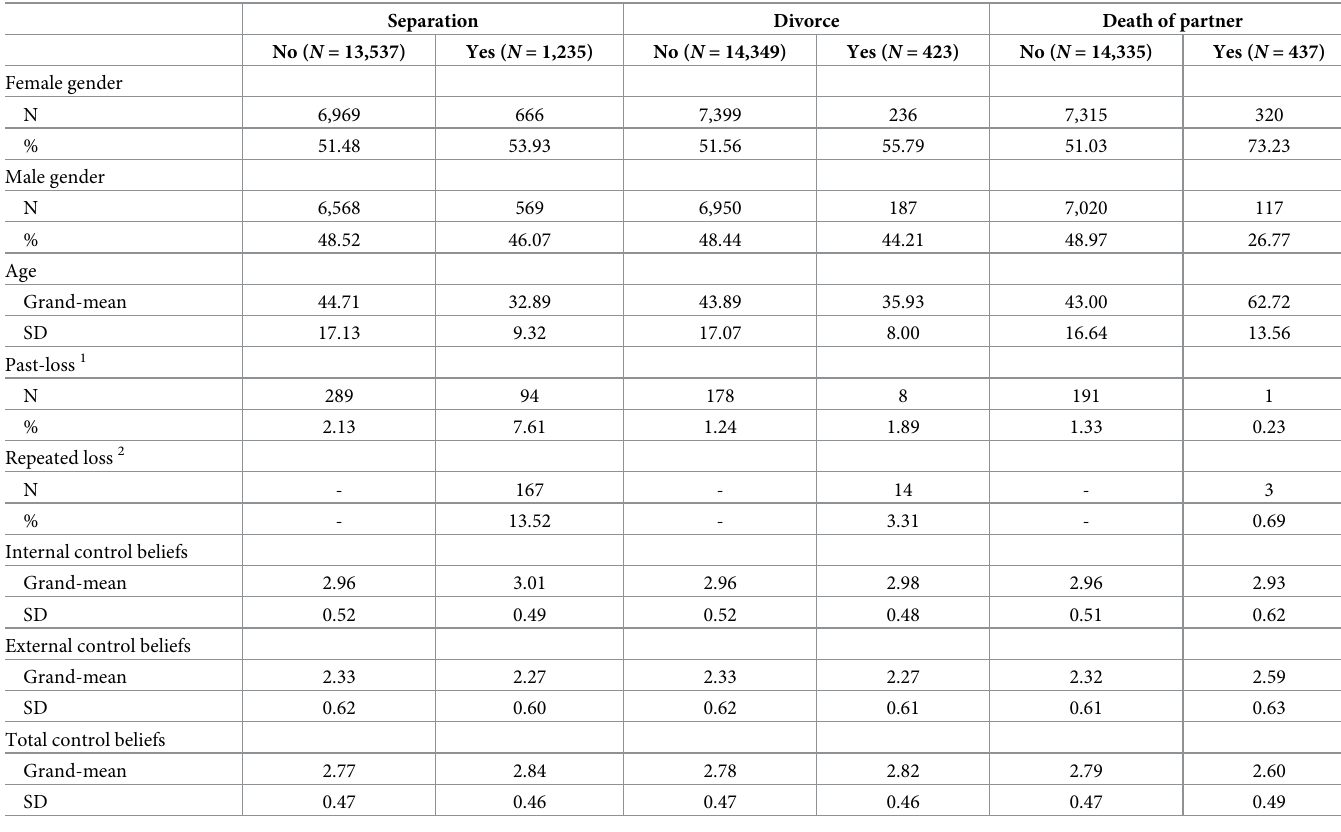
Table 3. Sample characteristics in individuals who did and did not experience the respective loss between 1991 and 1999 ( N =